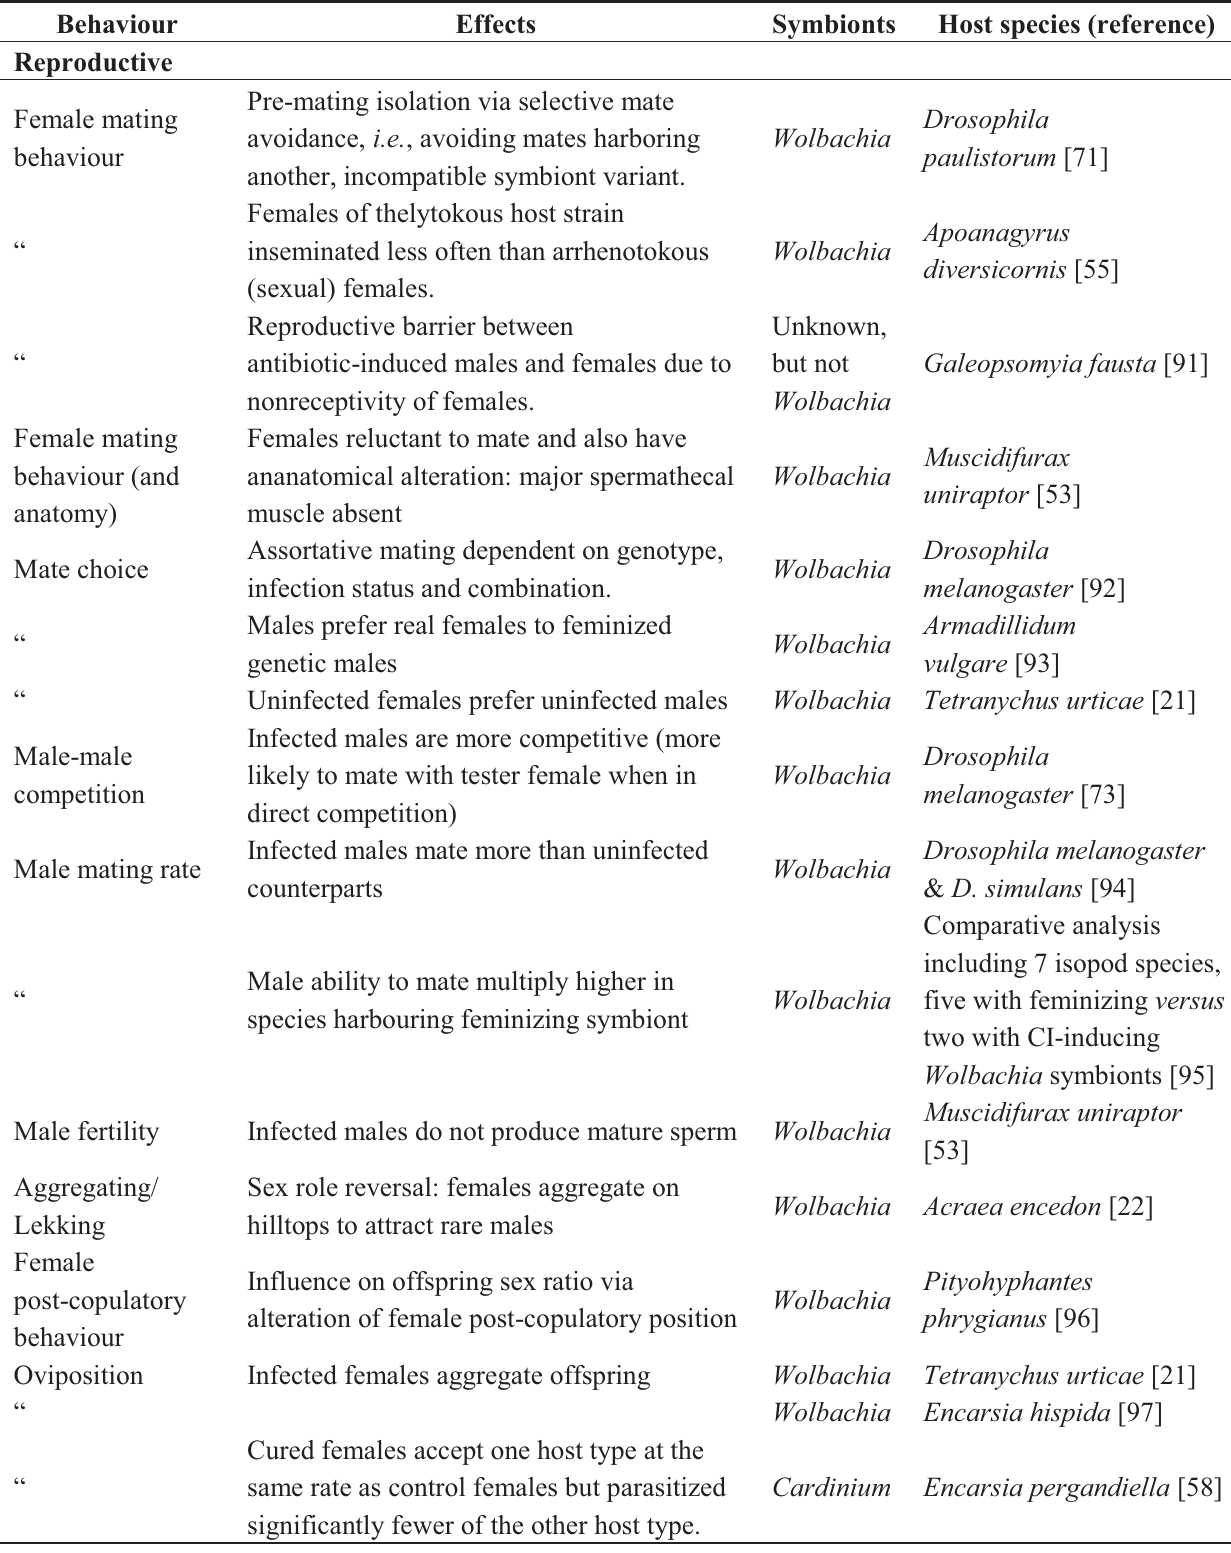
Table 4. Behavioural effects of infection with vertically acquired, endosymbiotic bacteria in arthropod